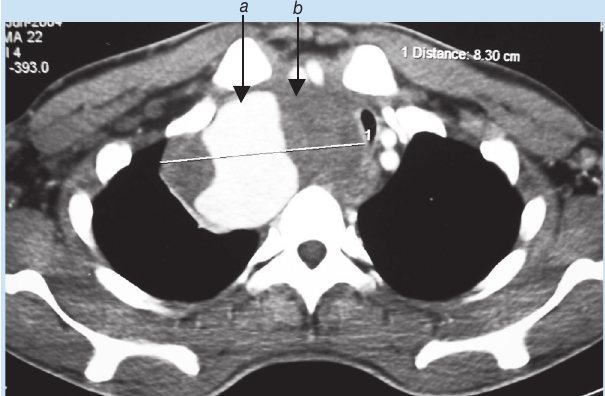
Fig. 9. Axial CT scan of the chest through the superior mediastinum: (a) false aneurysm of the brachiocephalic trunk with (b) associated mural thrombus. There is no extravasation of contrast from the vessels. The trachea is nar- rowed and deviated to the left.